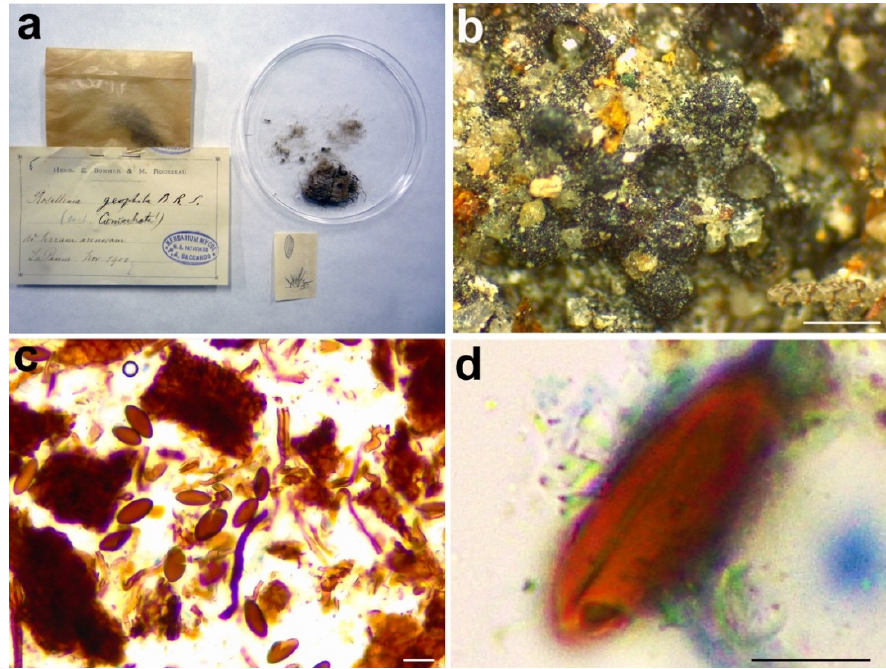
Figure 8. Rosellinia geophila . ( a ) Original fungarium specimen. ( b ) Perithecia on natural substrate. ( c ) Ascospores. ( d ) Ascospore showing germ slit. Scale bars: ( b ) = 500 μ m; ( c ) = 20 μ m; ( d ) = 10 μ m.